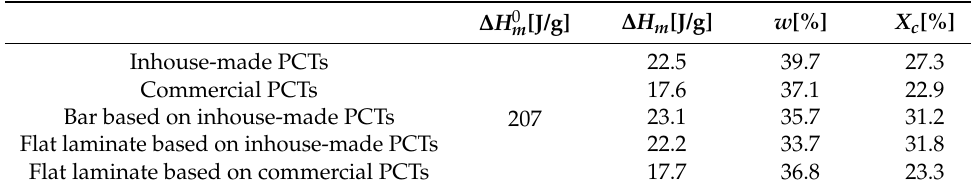
Table 1. Results of thermal analysis.